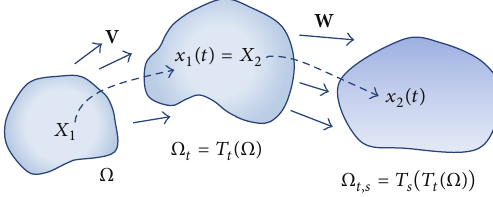
Figure 3: Transport of Ω after two